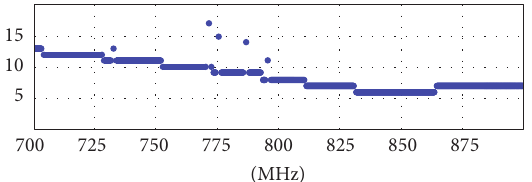
Figure 16: Number of iterations used in the tuning computation.